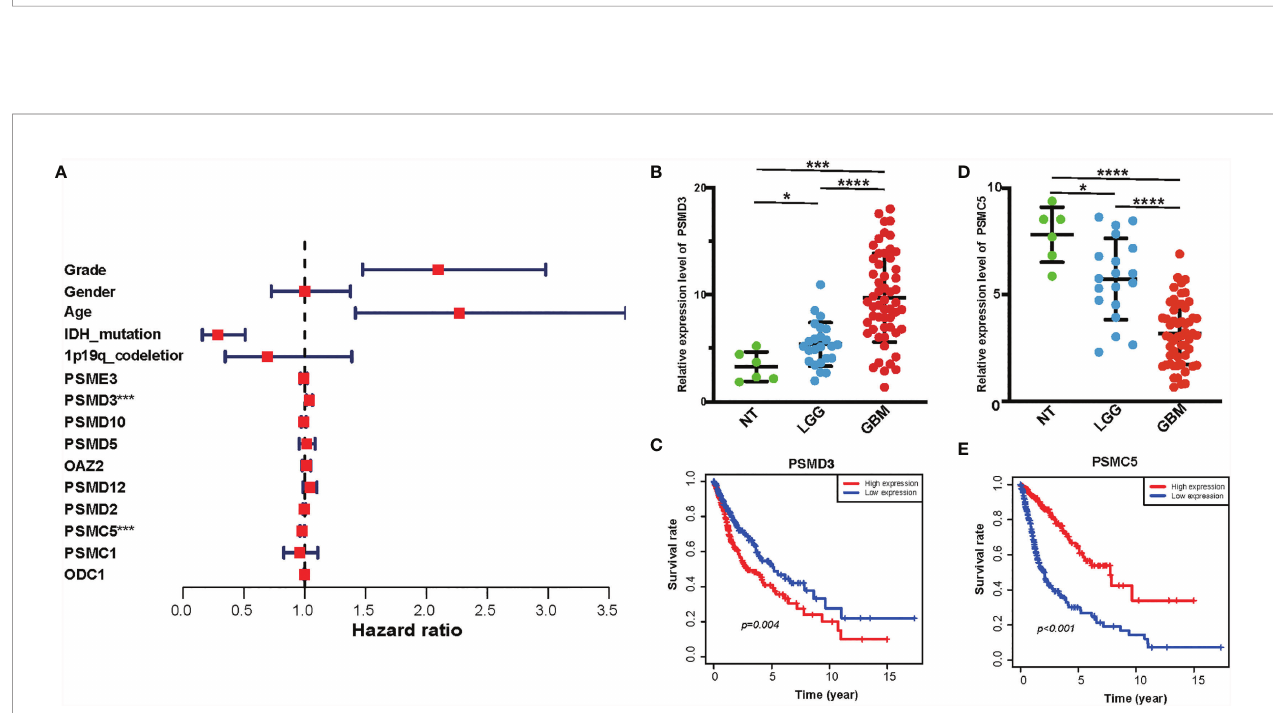
FIGURE 8 | Identi fi cation of hub genes of amino metabolism-related risk signature. (A) Forest plot of the multivariable Cox regression analysis of the effect of 10 hub genes and clinicopathological variables on the overall survival (OS) of glioma patients. (B) The relative expression level of PSMD3 in normal, low-grade glioma (LGG), and glioblastoma (GBM) tissues according to the rt-PCR results. (C) The OS survival analysis of PSMD3 in TCGA glioma. (D) The relative expression level of PSMC5 in normal, LGG, and GBM tissues according to the rt-PCR results. (E) The OS survival analysis of PSMC5 in TCGA glioma. *P < 0.05, ***P < 0.001, ****P < 0.0001.